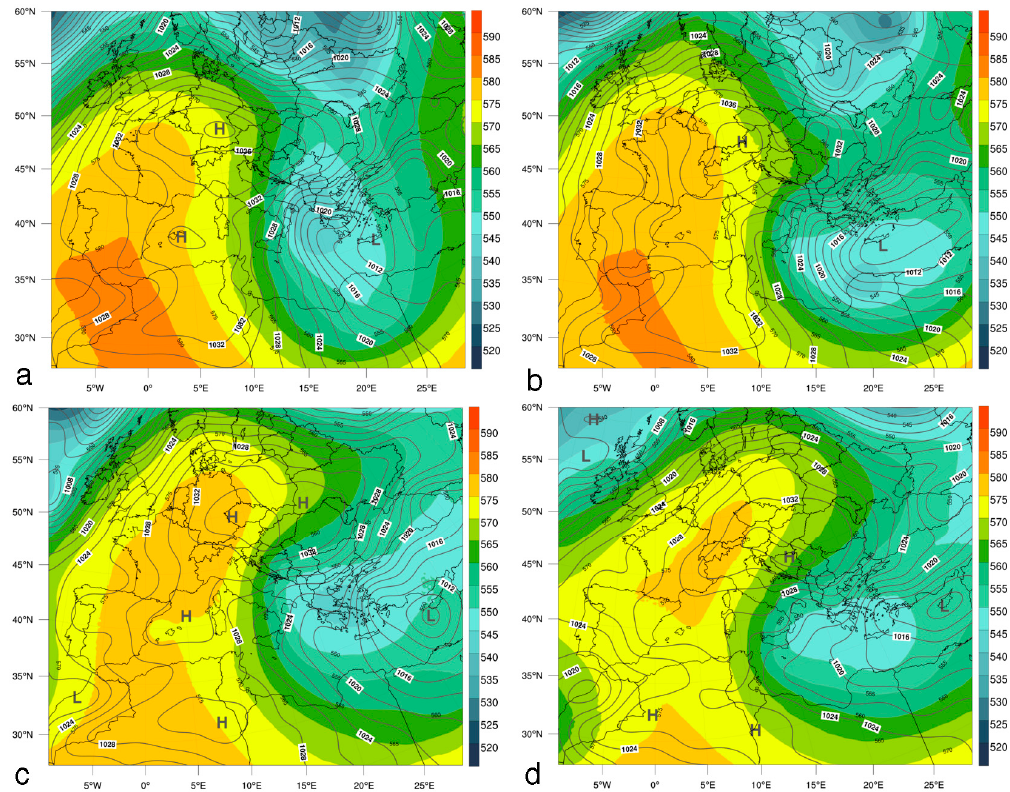
Figure 4. NCEP FNL analysis of 500-hPa geopotential height (shading at 50-gpdm intervals), sea-level pressure (thin black contours at 2-hPa intervals), valid at ( a ) 1200 UTC 13 February 2019, ( b ) at 0000 UTC 14 February 2019, ( c ) at 1200 UTC 15 February 2019, and ( d ) at 0000 UTC 16 February 2019.